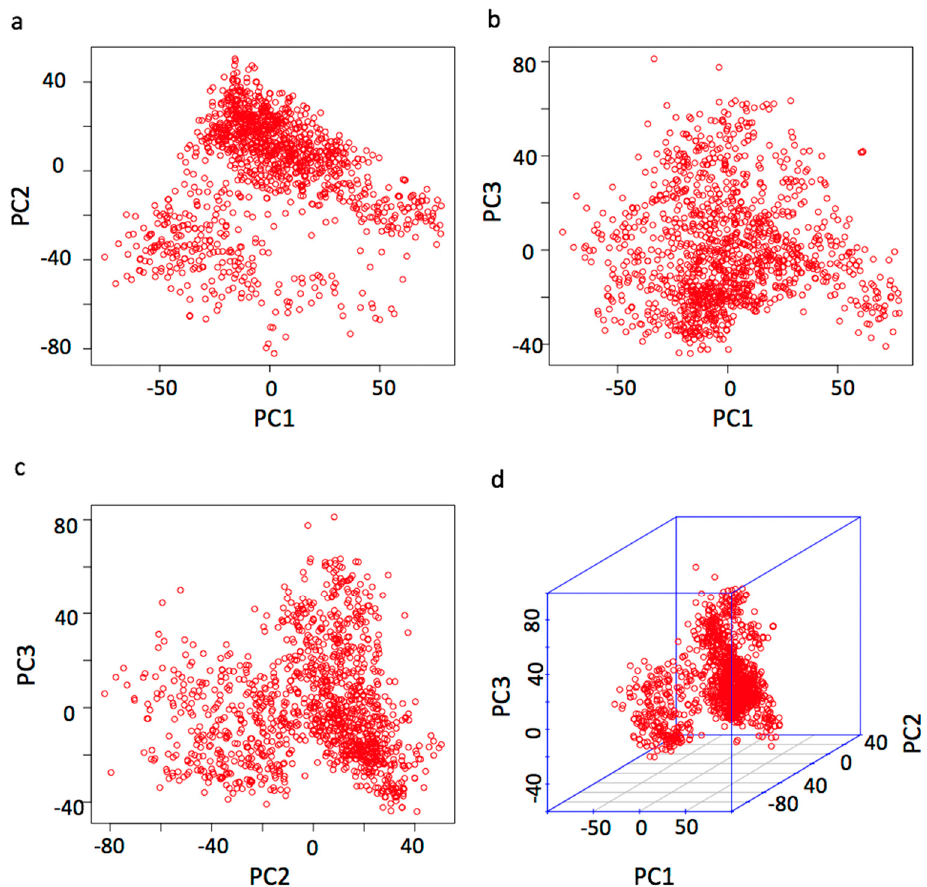
Figure 2. Population structure demonstrated by principal component analysis. Principal component analysis (PCA) was conducted with the 124,743 SNPs for the 1220 cows. The population structure is demonstrated by the pairwise scatter plots ( a – c ) and the 3D plot ( d ) of the first three principal components (PCs).